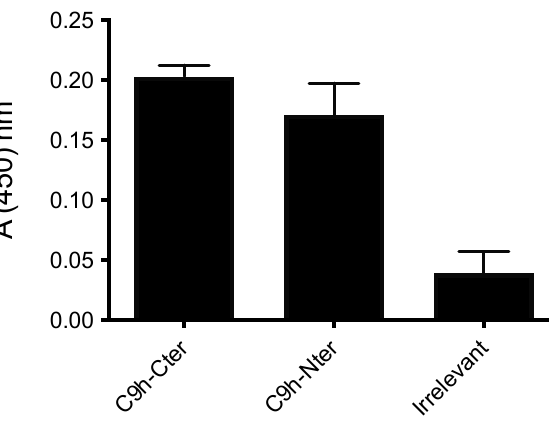
Figure 5. Detection of PP2A binding to C9h peptide by ELISA. Biotinylated C9h-Cter and C9h-Nter biotinylated peptides were immobilized on a Streptavidin-coated plate and incubated overnight with PP2A catalytic subunit at 0.6 μ g/mL. After washing, rabbit anti-PP2A was added in each well and incubated 1 h at room temperature. Wells were washed and filled with a dilution of HRP-conjugated anti-Rabbit secondary antibody. Binding activity of PP2A is expressed as mean OD at 450 nm of duplicate wells, and bars indicate SD. These data are representative of two independent experiments.